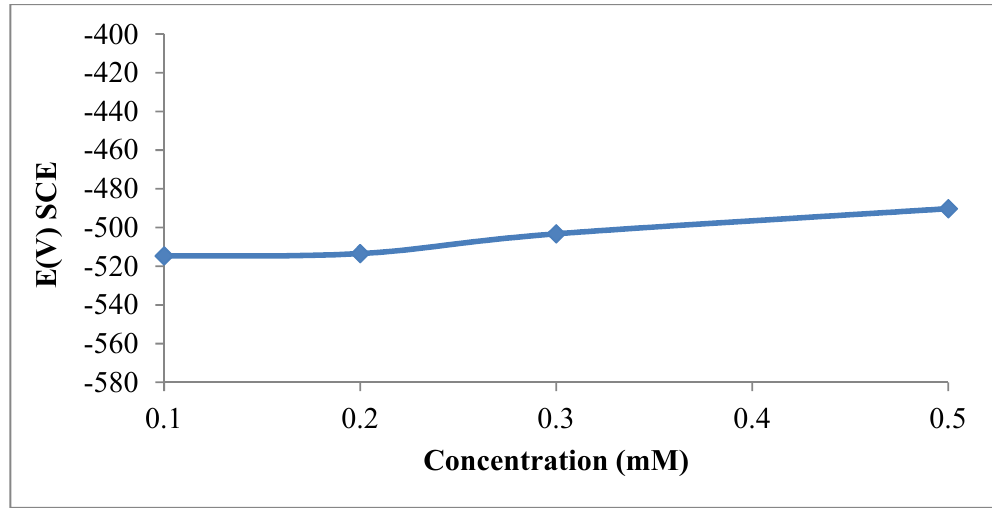
Figure 3. Open circuit potential (OCP) value for mild steel in an HCl solution with various concentrations of DMPO at 30 °C.